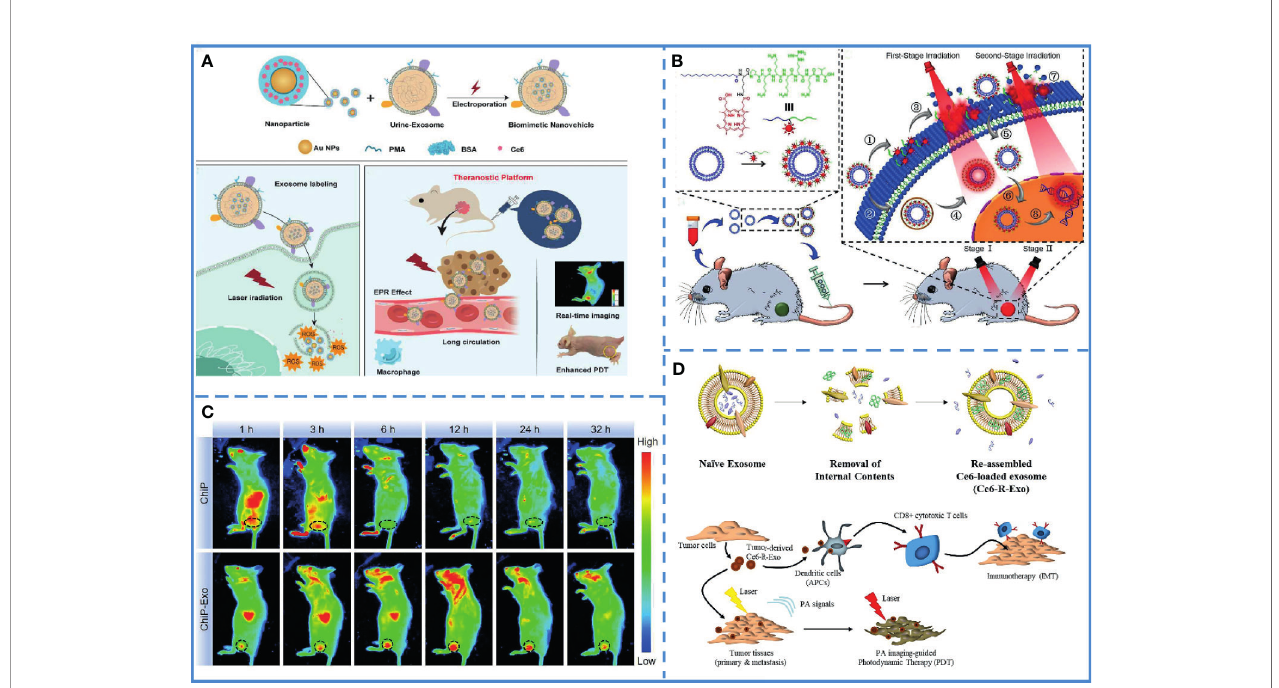
FIGURE 6 | Photodynamic therapy. (A) Synthesis of Exo-PMA/Au-BSA@Ce6 nanovehicles. Laser irradiation at 633 nm under acidic conditions resulted in the collapse of the structure of nanovehicles, leading to the release of PMA/Au-BSA@Ce6 nanoparticles into the cancer cells, producing singlet oxygen species, inhibiting tumor cell growth. Reproduced with permission from ref (63). Copyright 2019 Elsevier. (B) Intravenous injection of ChiP-Exo and dual-stage light-guided PDT against the tumor. ChiP-Exo underwent the following steps: (1) PM-targeted delivery; (2) Endocytic delivery; (3) PM fl uctuation; (4) Lysosomal escape after the fi rst-stage light irradiation; (5) Photochemical internalization (PCI); (6) Nucleus-targeted translocation; this was followed by (7) PM rupture, and (8) Nucleus destruction under the second-stage light irradiation. Reproduced with permission from ref (175). Copyright 2019 Elsevier. (C) ChiP has several limitations, including a relatively shorter half- life in vivo and poor retention in tumor tissues. On the contrary, ChiP-Exo continuously accumulates in the tumor and exhibits superior tumor treatment ability. Reproduced with permission from ref (175). Copyright 2019 Elsevier. (D) Combined photodynamic therapy and immunotherapy via exosomes to treat tumors. Reproduced with permission from ref (176). Copyright 2020